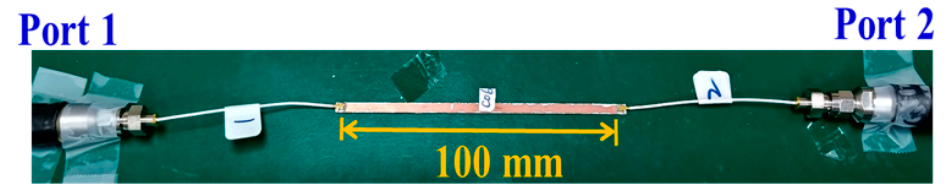
Figure 8. Measurement setup with the test structure and two SMT to SMA cables.